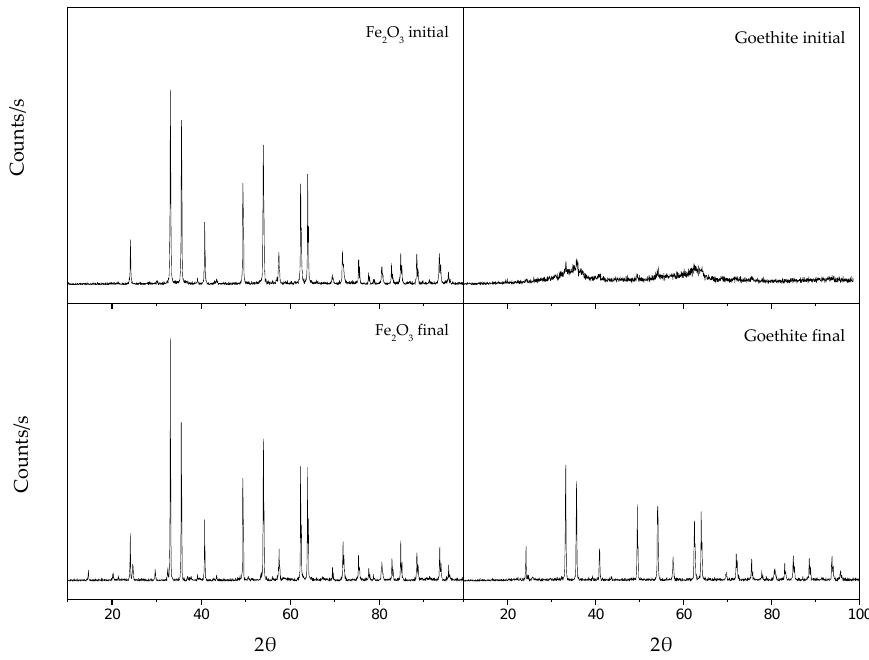
Catalysts 2021 , 11 , x FOR PEER REVIEW Figure 6. XRD of the initial and final Fe 2 O 3 and goethite. Figure 6. XRD of the initial and final Fe 2 O 3 and goethite.